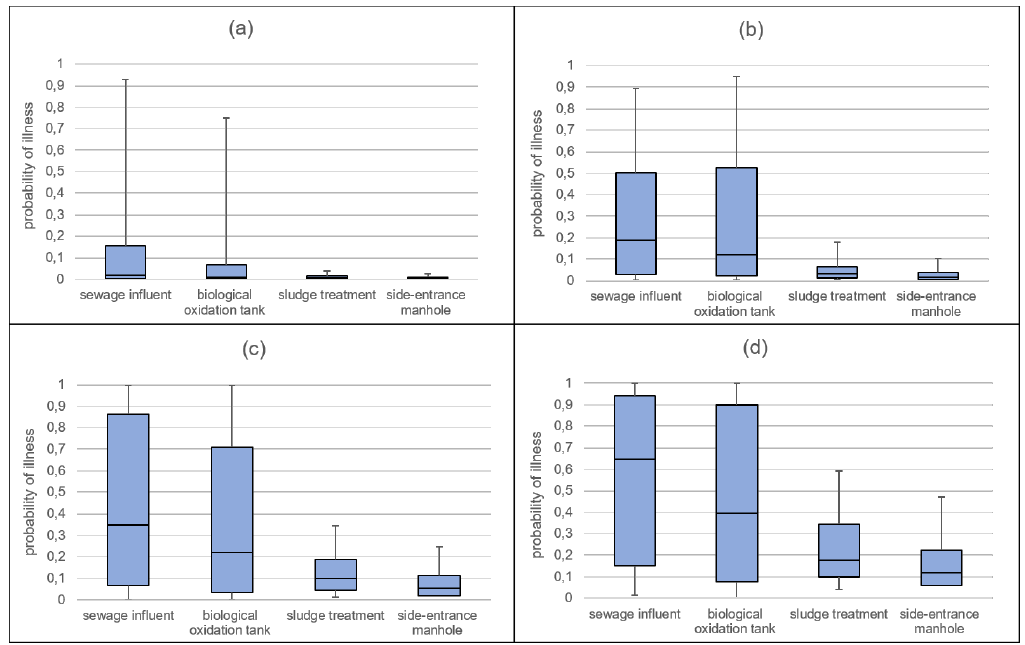
Figure 3. Probability of illness P ill (5th, 25th, 50th, 75th and 95th) in the considered work settings and for different exposure times: 0–3 min ( a ); 3–5 min ( b ); 5–10 min ( c ); 10–15 min ( d ).